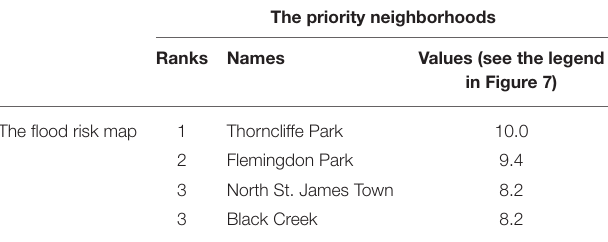
TABLE 5 | The priority neighborhoods and their normalized risk